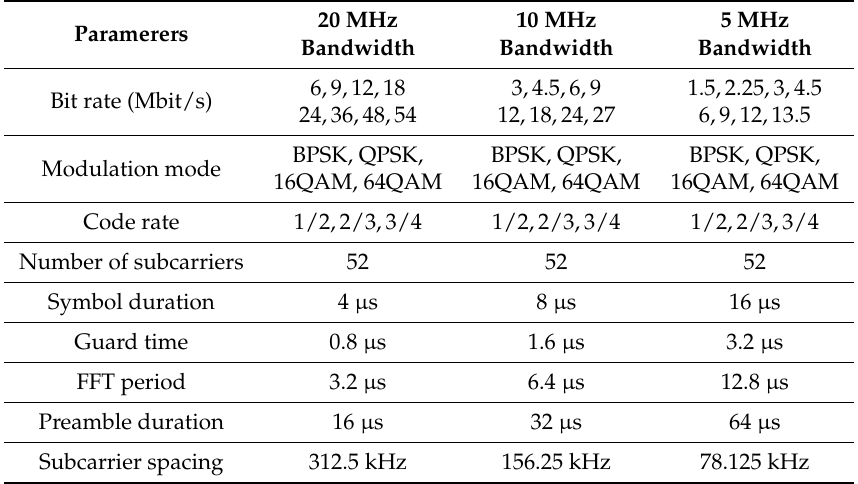
Table 2. IEEE 802.11 OFDM PHY parameters concerning the channel